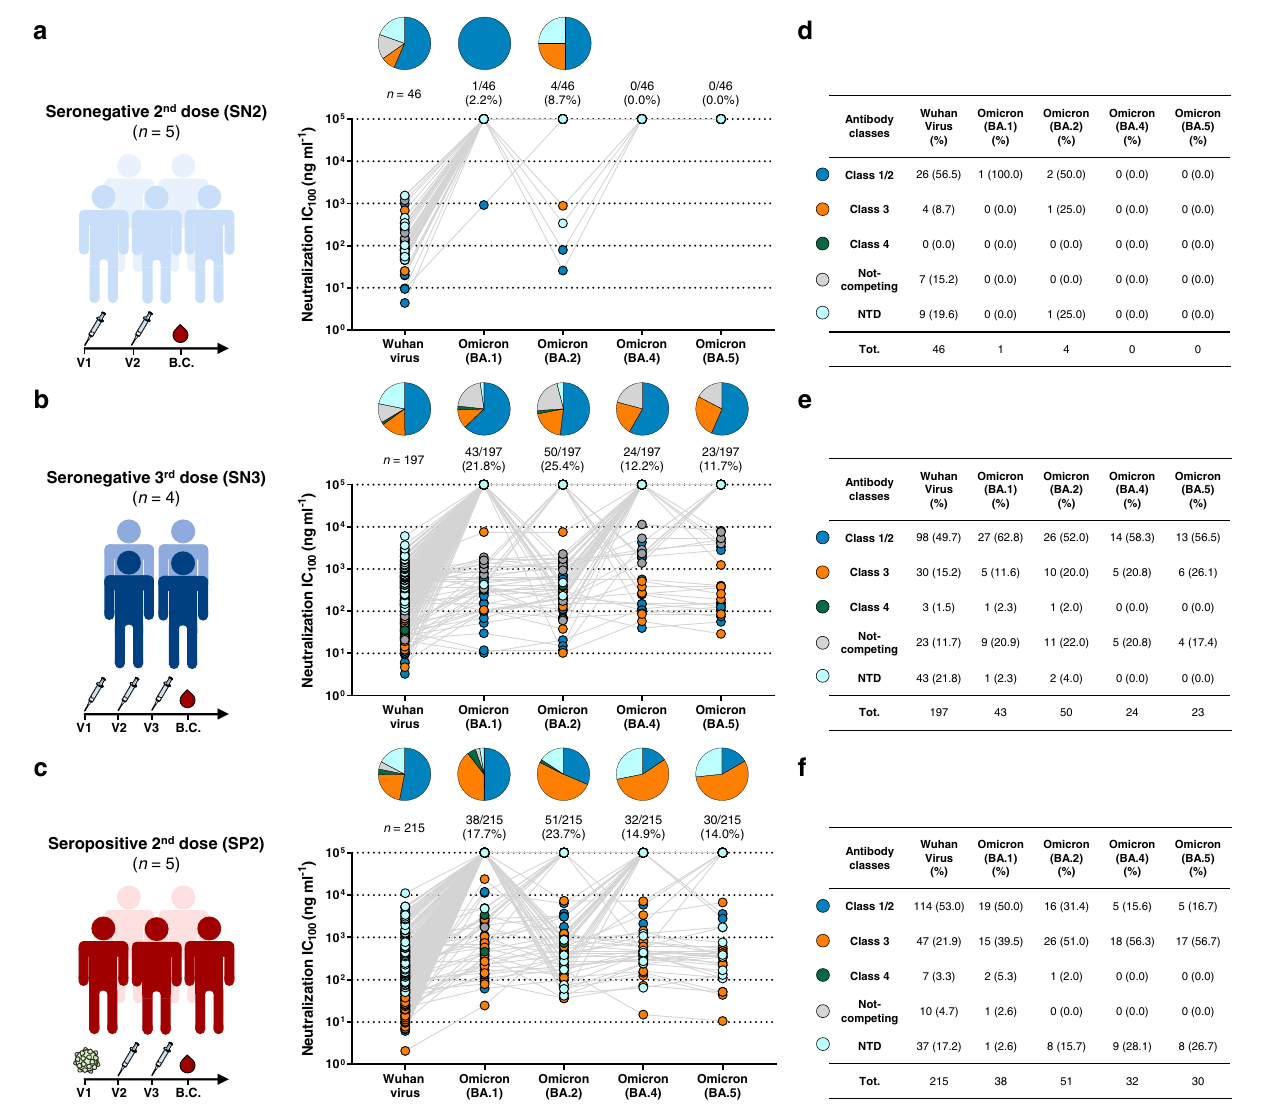
Fig. 2 | Distribution ofRBD and NTD-targeting nAbsagainstOmicronvariants. Pie charts show the distribution of cross-protective nAbs based on their ability to bind Class 1/2(blue),Class 3 (orange) and Class 4 (dark green) regions on the RBD, as well as not-competing nAbs (gray) and NTD-targeting nAbs (cyan). Dot charts show the neutralization potency, reported as IC 100 (ng ml − 1 ), of nAbs against the Wuhan virus and the Omicron BA.1, BA.2, BA.4 and BA.5 variants observed in the